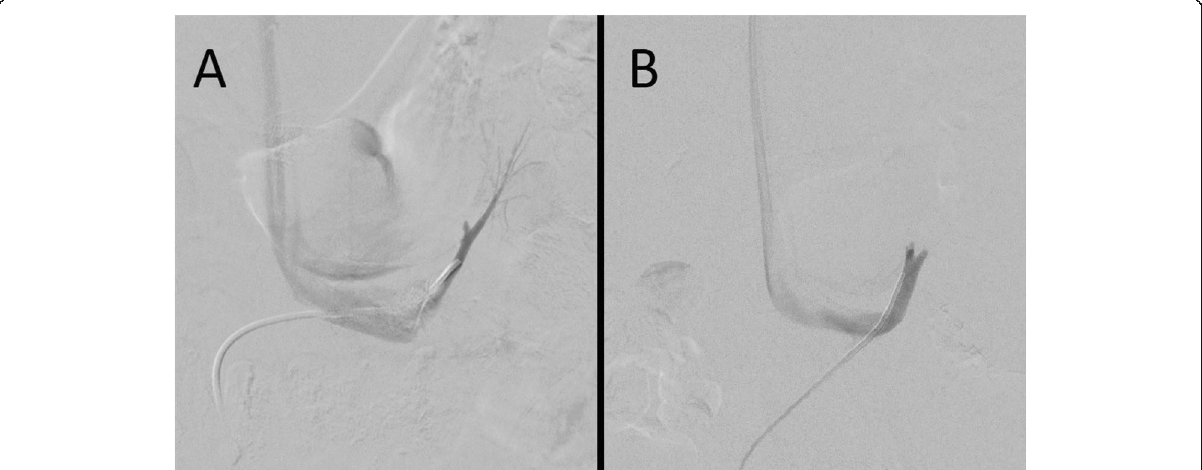
Fig. 4 Venographic appearance of the left adrenal vein. In both A + B a Simmons-2 catheter is used to select the left renal vein and then the common phrenic adrenal trunk. In a , contrast refluxes into the adrenal branch (lateral). In b , the common trunk and a small part of the inferior phrenic vein (medial) and the left adrenal vein (lateral) are seen. Reflux of contrast into the adrenal vein proper is not necessary to confirm correct location